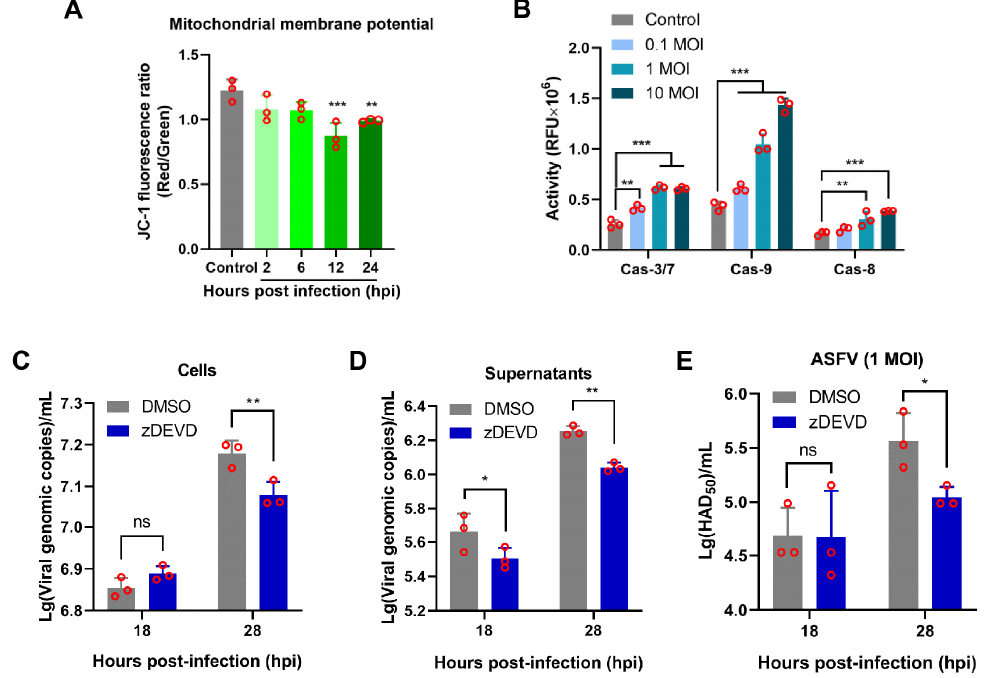
Figure 6. Inhibition of ASFV-induced apoptosis by caspase-3 inhibitor restricted viral growth. ( A ) Analysis of the mitochondrial membrane potential in ASFV-infected PAMs. In total, 10,000 PAMs infected with 1 MOI ASFV HLJ/18 were analyzed at 2, 6, 12, and 24 hpi by flow cytometry as described in Materials and Methods. Non-infected PAMs served as the control. ( B ) Detection of caspase-9, caspase-3/7, and caspase-8 activity in ASFV-infected PAMs. PAMs were infected with ASFV HLJ/18 at an MOI of 0.1, 1, or 10 for 24 hpi, and the activities of caspase-9, caspase-3/7, and caspase-8 were analyzed as described in the Materials and Methods. ( C – E ) The effect of apoptosis on ASFV replication was analyzed. PAMs pretreated with z-DEVD-FMK (200 µ M) were infected with ASFV HLJ/18 at 1 MOI for 1 h and then cultured with z-DEVD-FMK again for 18 and 28 hpi. The viral growth in the cells ( C ) and supernatants ( D ) was determined with viral p72 gene copies via qPCR or the viral titers in supernatants were detected via the HAD assay ( E ). The significance of